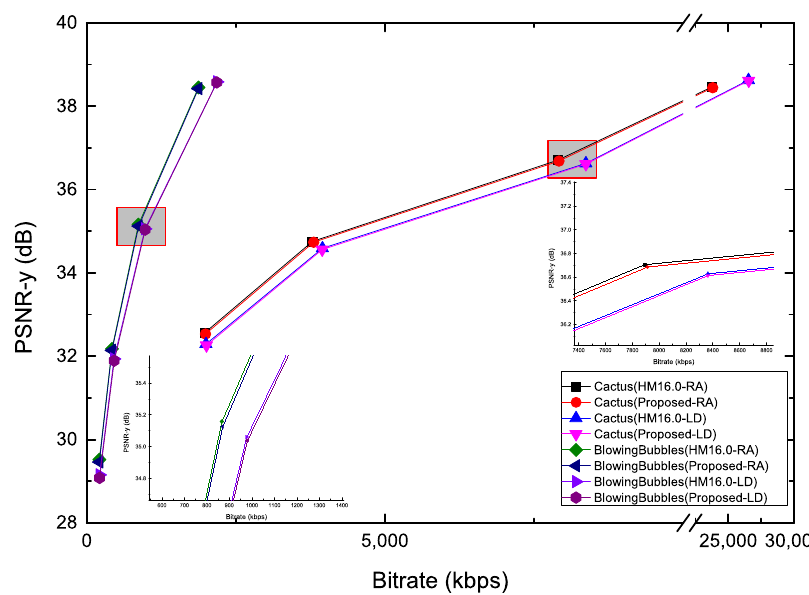
Figure 10. Rate–distortion (R–D) curve of the proposed method for “Cactus” and “BlowingBubbles”.